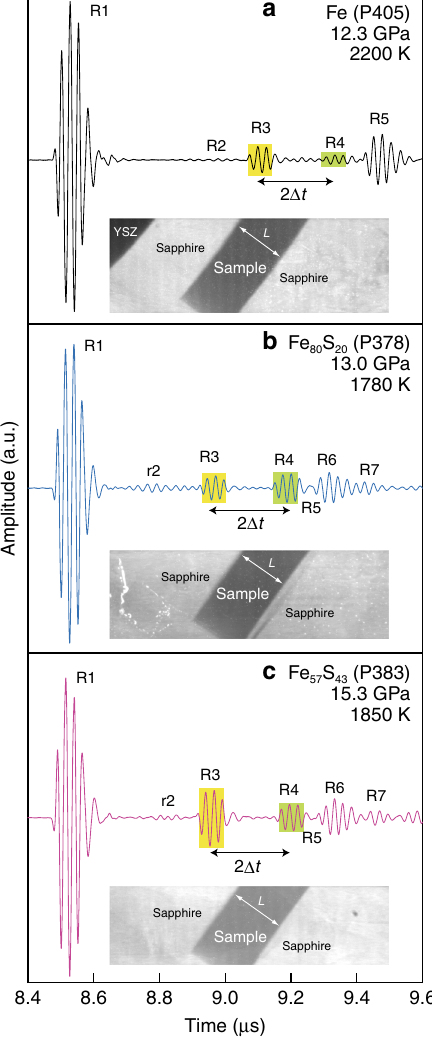
Fig. 1 Examples of ultrasonic waveform and X-ray radiographic image of a fully molten sample. ( a ) Fe, ( b ), Fe 80 S 20 , and ( c ), Fe 57 S 43 . R1 – R7 represent echo signals by 3-cycle sine-wave burst with a center frequency of 40 MHz from the following boundaries; R1 = anvil/buffer-rod, R2 = YSZ/ sapphire, r2 = ZrO 2 /Al 2 O 3 (surroundings), R3 = fronting sapphire/sample, R4 = sample/backing sapphire, R5 = sapphire/pressure marker ( a ) sapphire/c-BN ( b , c ), R6 = c-BN/pressure marker, R7 = pressure marker/ MgO. See more detail in Supplementary Fig. 7. L in X-ray radiographic image represents sample length; 517.7(5) μ m for Fe, 507.7(1) μ m for Fe 80 S 20 and 541.7(6) μ m for Fe 57 S 43 . 2 Δ t in ultrasonic waveform represents two-way travel time in the sample; 221.1ns for Fe, 217.0ns for Fe 80 S 20 and 241.7ns for Fe 57 S 43 . Sound velocity ( V P ) can be obtained as L / Δ t